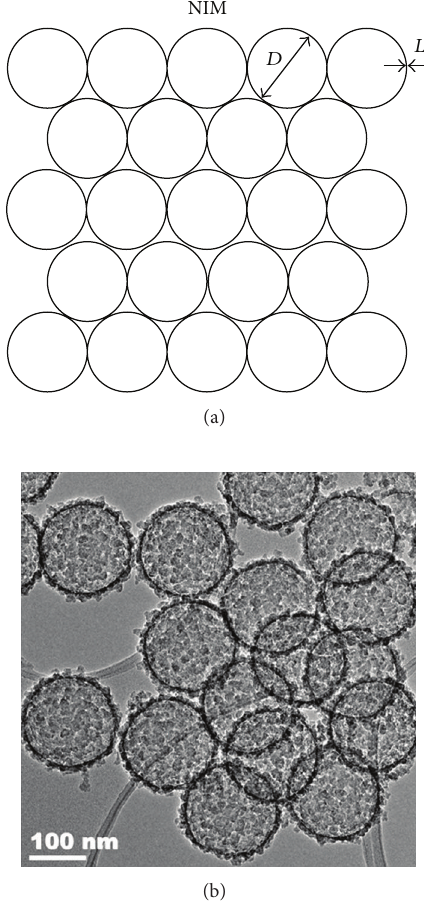
Figure 1: Conceptual model of a hollow nanosphere NIM with a description of the pore size 𝐷 and shell thickness 𝐿 (a) and a representative TEM image of hollow silica nanospheres (b)